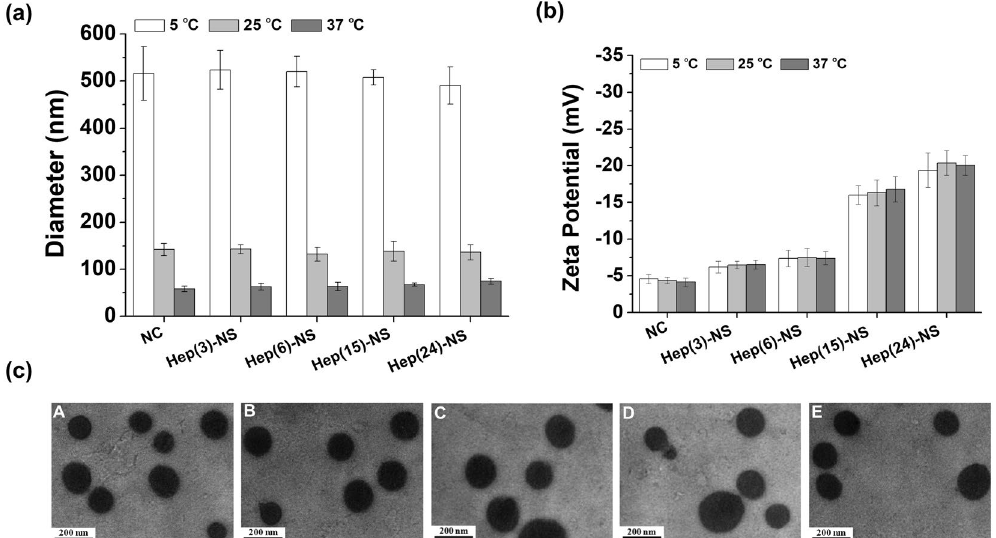
Figure 2. ( a ) Hydrodynamic diameters and ( b ) surface charges (zeta-potential) of nano-carrier (NC) and heparin nanosponge (Hep-NS) at 5 °C, 25 °C, and 37 °C. Hep(X)-NS denotes the amount of heparin (X wt%) in relation to the nanosponge. ( c ) TEM images of (A) NC, (B) Hep(3)-NS, (C) Hep(6)-NS, (D) Hep(15)-NS, and (E) Hep(24)-NS. Scale bar: 200